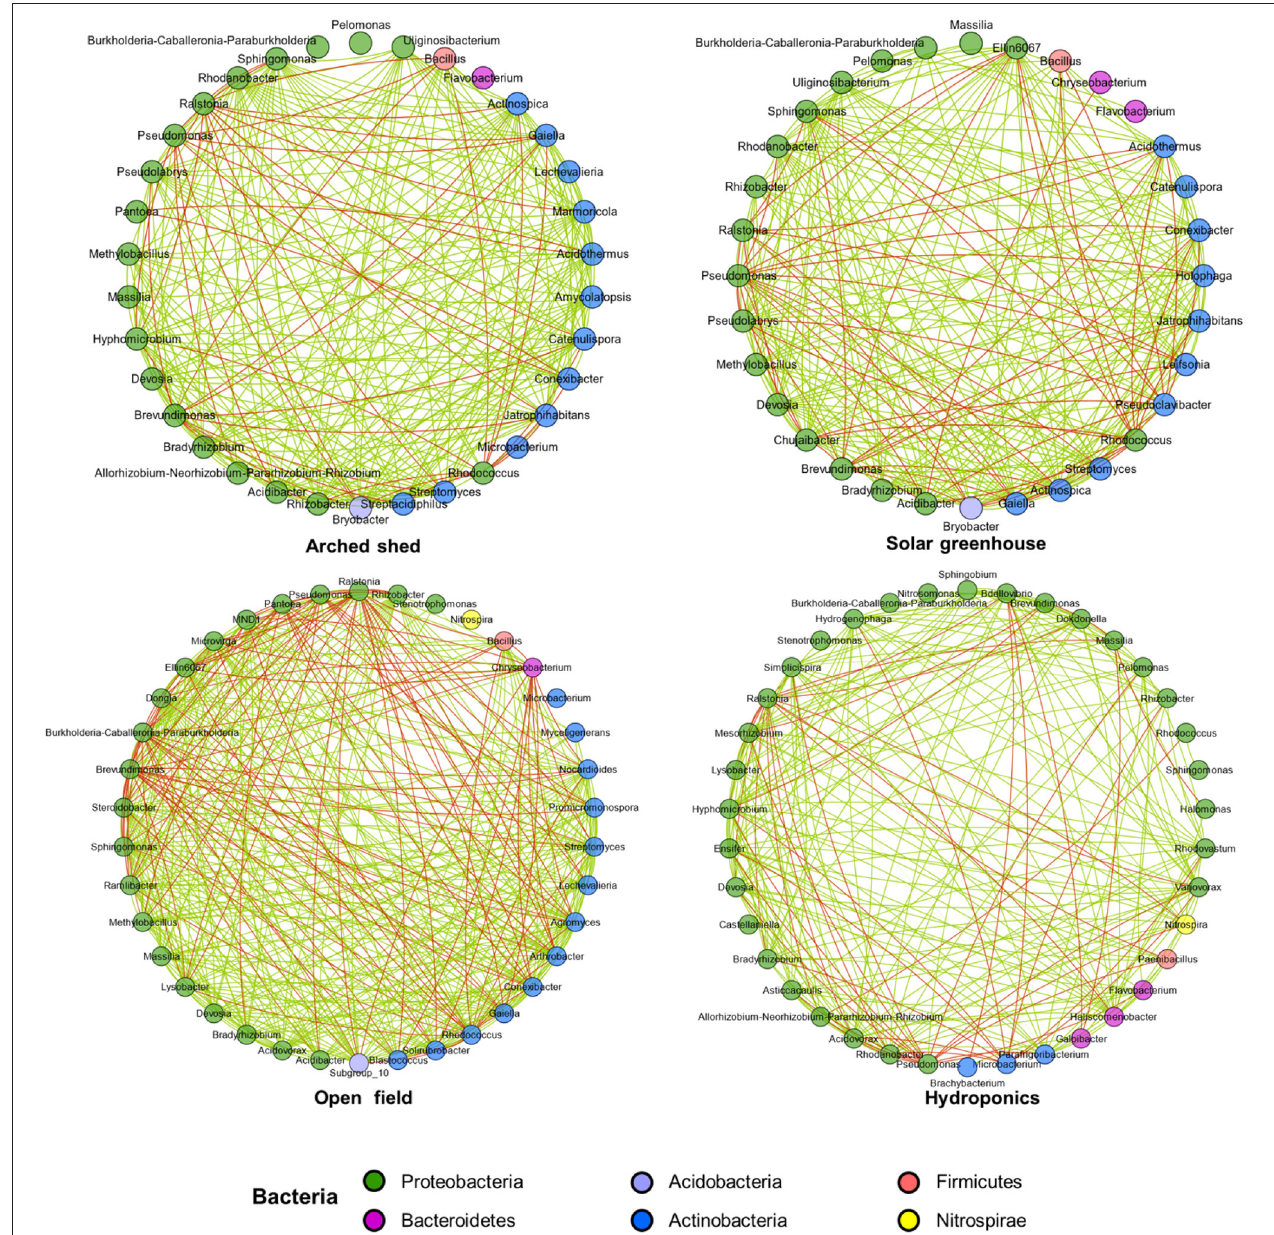
FIGURE 4 | Patterns of interaction of bacteria in different growth conditions. Spearman’s test was used to analyze the interactions among the top 50 bacterial OTUs by abundance. Only a significant correlation ( P < 0.05) is shown as a line. Line color indicates positive (green) or negative (red) correlation depending on the Spearman correlation coefficient. These nodes represent microbial genera, and their colors represent microbial